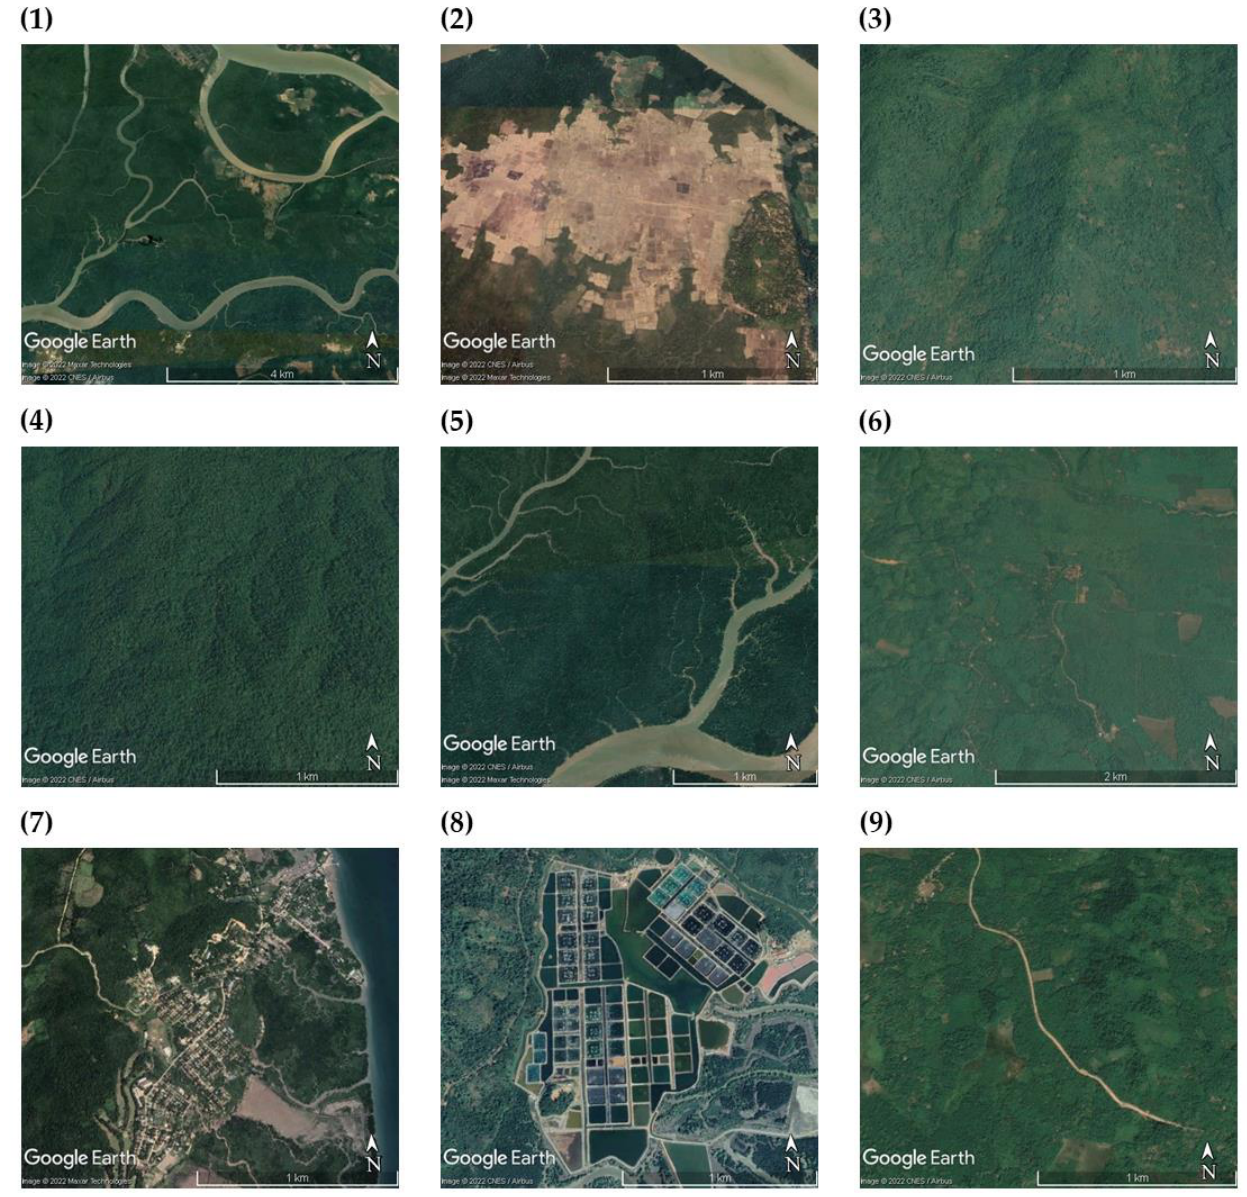
Figure 2. Land use and land cover (LULC) features/classes of Kyunsu township in Southern Myan- mar representing ( 1 ) Water Bodies (river networks), ( 2 ) Paddy Fields (post-harvest condition without vegetation), ( 3 ) Open Forests, ( 4 ) Closed Forests, ( 5 ) Mangrove Forests, ( 6 ) Plantations, ( 7 ) Settlement Areas, ( 8 ) Aquaculture Areas, and ( 9 ) Others (road). Source: Google Earth Pro 7.1.